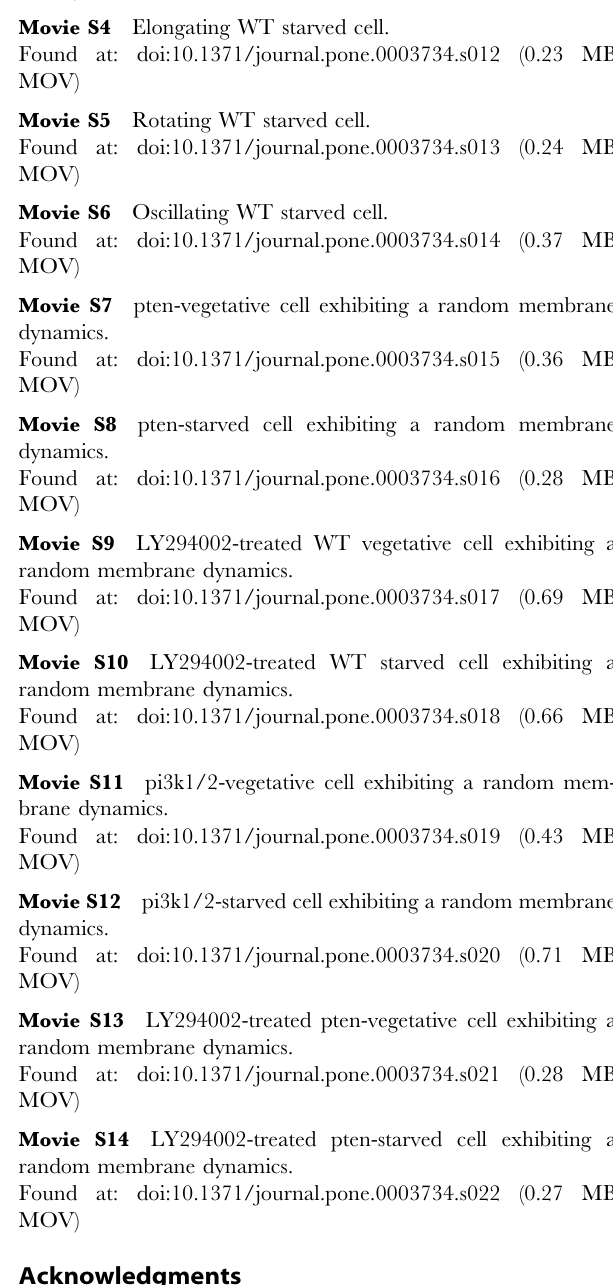
Figure S2 Multiple pseudopodia due to loss of PTEN. Typical pten &minus cells in VEG state. White arrowheads represent irregular pseudopodia. Scale bar is 10 m m. The number indicates time of measurement [second].